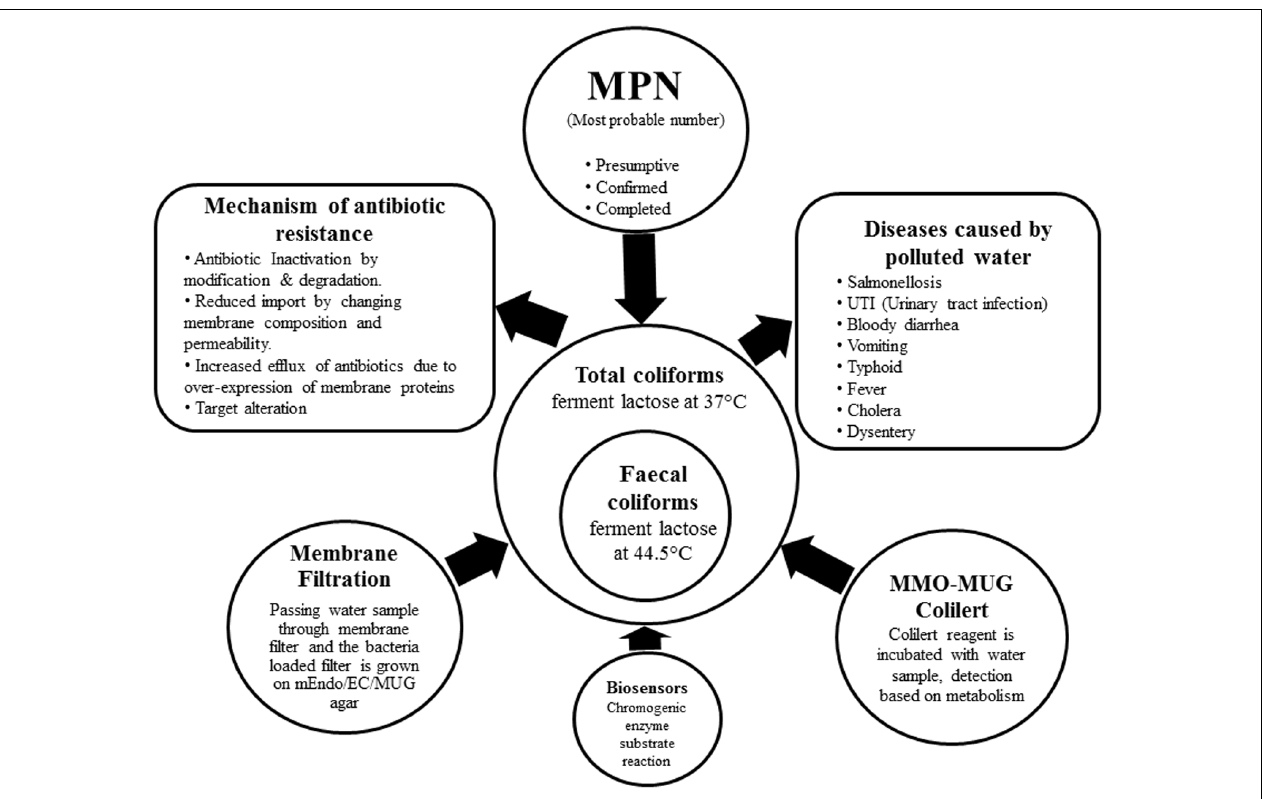
FIGURE 1 | The figure lucidly depicts the categorization of coliforms into total coliforms including both soil intermediates and from faecal origin and strictly faecal coliforms. The different methods of detection of coliform from water sample are enumerated. Mechanism of antibiotic resistance developed by coliform and diseases caused by the use of polluted water have been illustrated in the